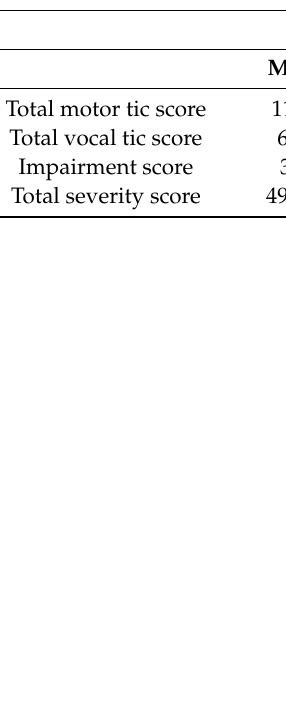
Table 3. Comparison of the CPRS scores between TPM group and Tiapride group.